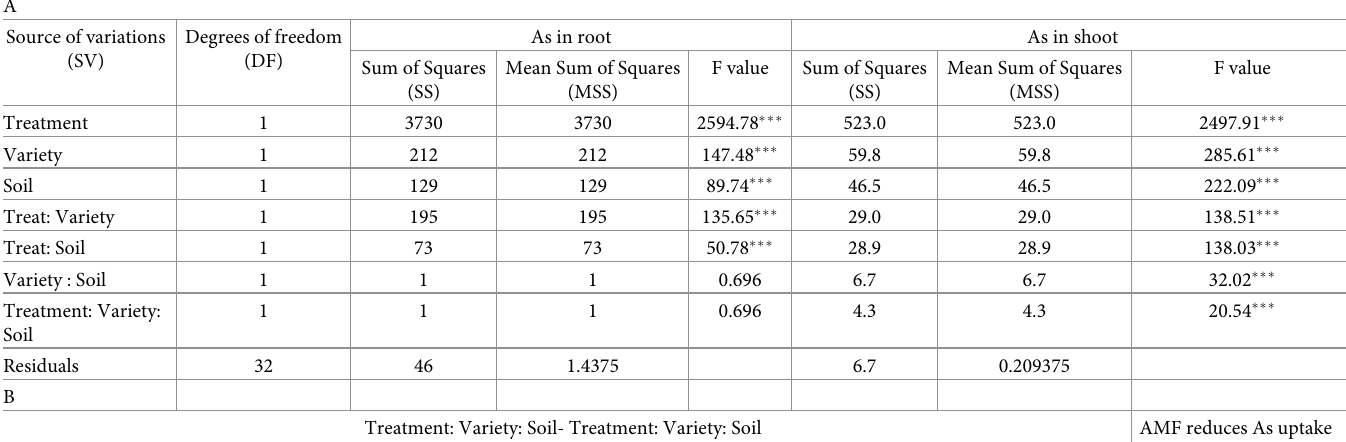
Table 5. AMF reduce As uptake in root and shoot of lentil genotypes according to the interaction between treatments, varieties and